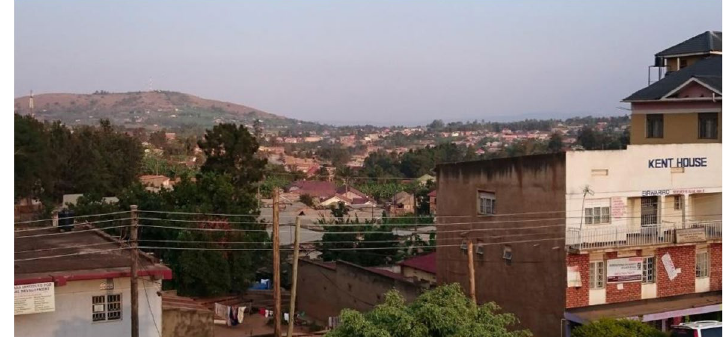
Fig. 3 View over central Mbarara, 2018. Source: Mackay,